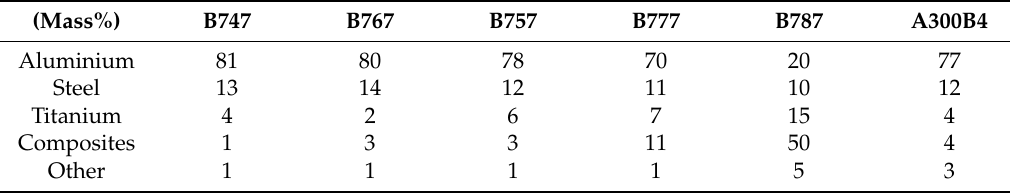
Table 1. Composition of selected airliner models [4].